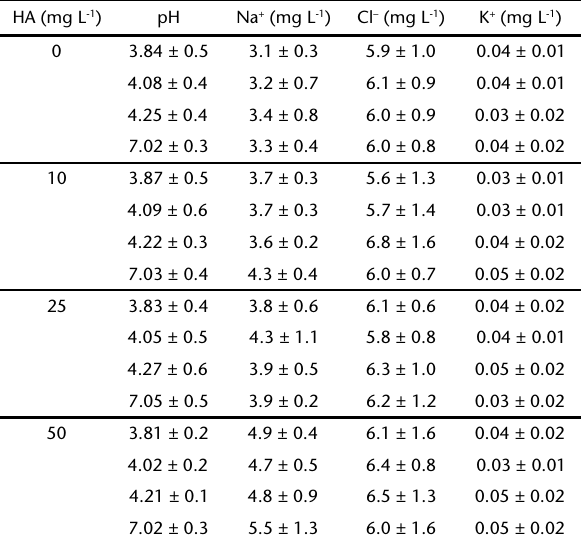
Table 1. Ion levels in water at different pH and humic acid (HA) levels for Rhamdia quelen . HA (mg L -1 ) pH Na + (mg L -1 ) Cl – (mg L -1